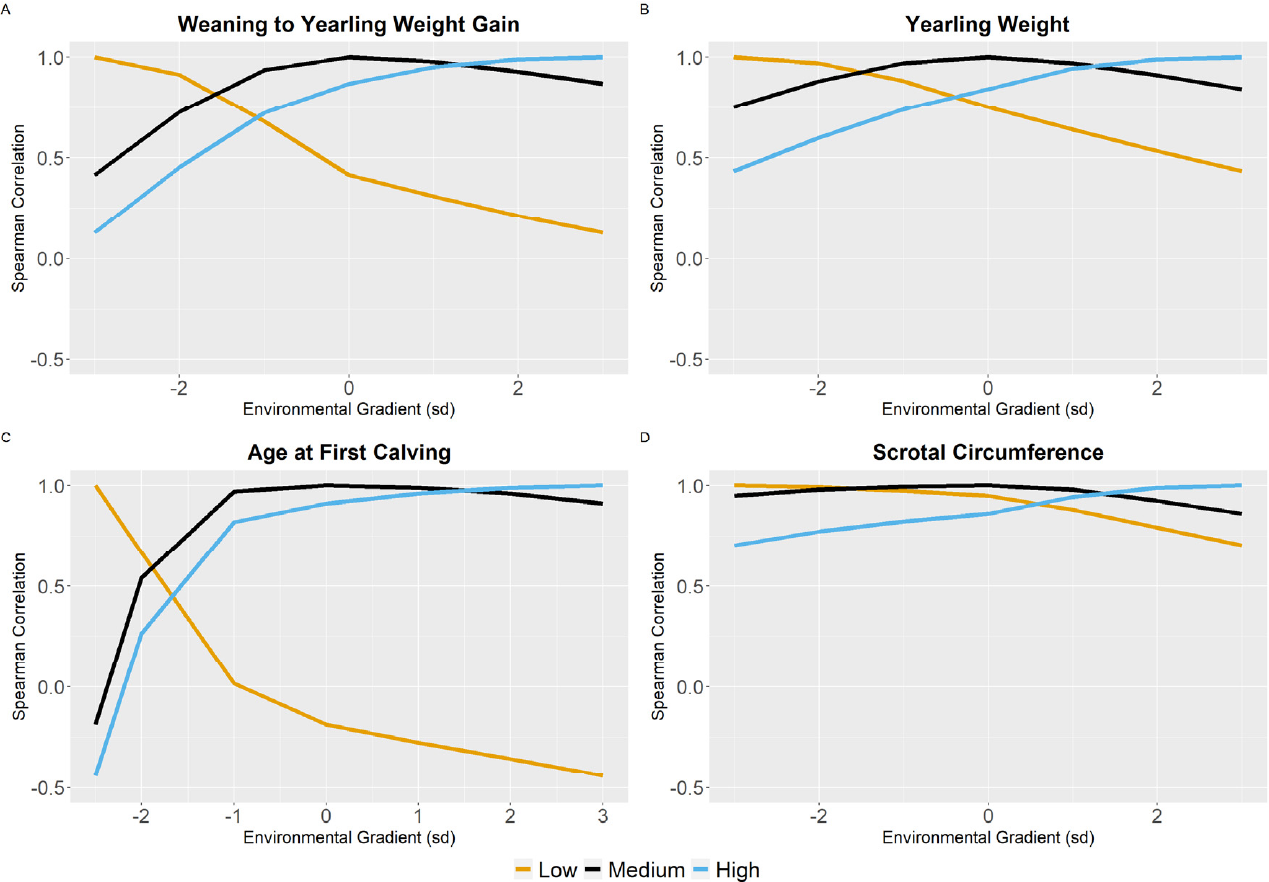
Figure 4. Estimates of Spearman correlation between sire’s EBVs for low, medium, and high gradients along the environmental gradient for weaning to yearling weight gain ( A ), yearling weight ( B ), age at first calving ( C ), and scrotal circumference ( D ).